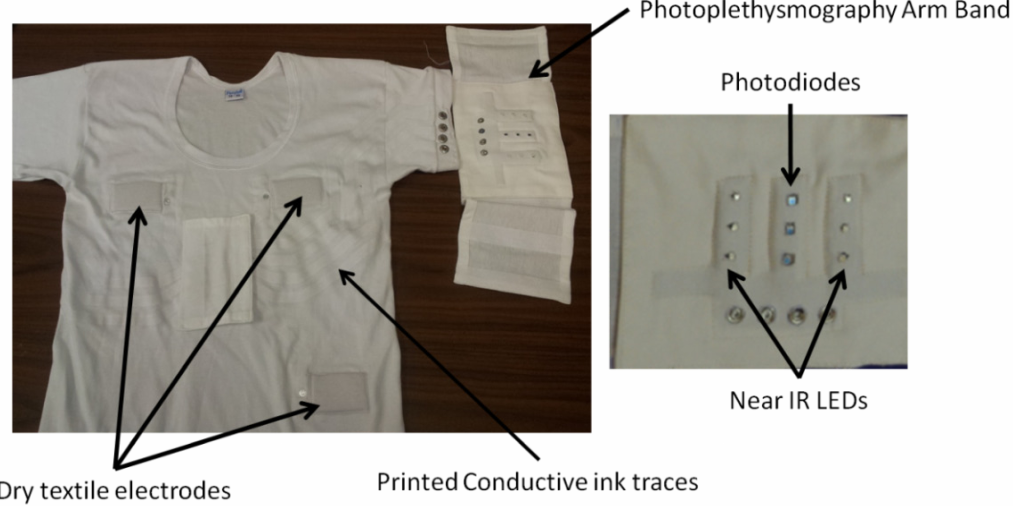
Figure 2. E-bro and the photoplethysmography arm band. Reproduced with permission from [47]. Copyright 2014, The Electrochemical